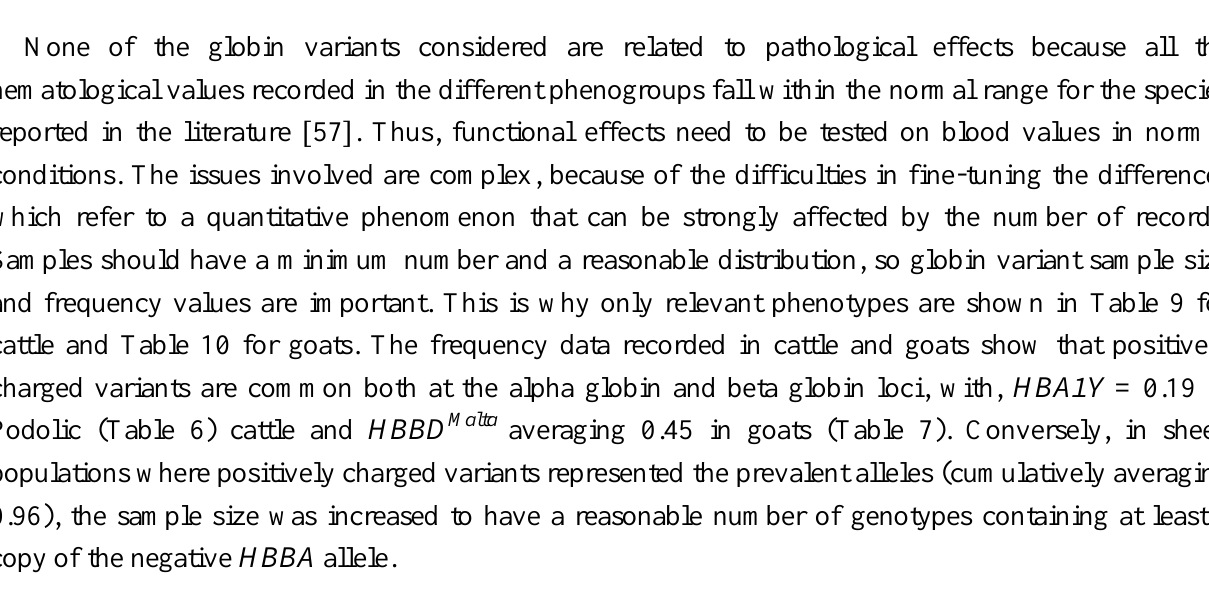
Table 9. Least square mean values and standard error (s.e.) of hematocrit values (Hct) and hemoglobin (Hb) for relevant globin gene arrangements in Podolic cattle. Means with different superscripts differ significantly (P <